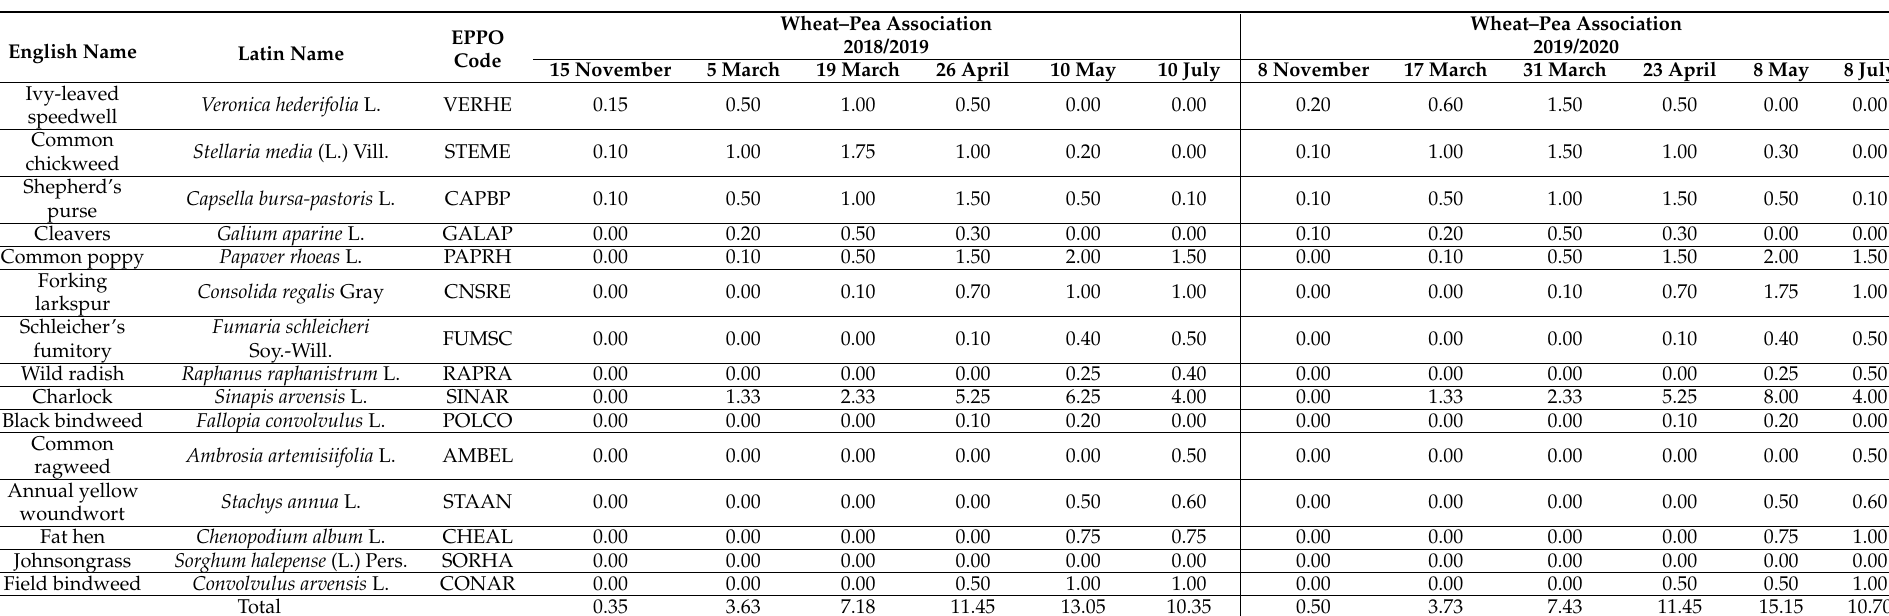
Table 6. Weed cover (%) of winter wheat ( Triticum aestivum L.)–winter pea ( Pisum sativum L.) plant association without weed management in control plots